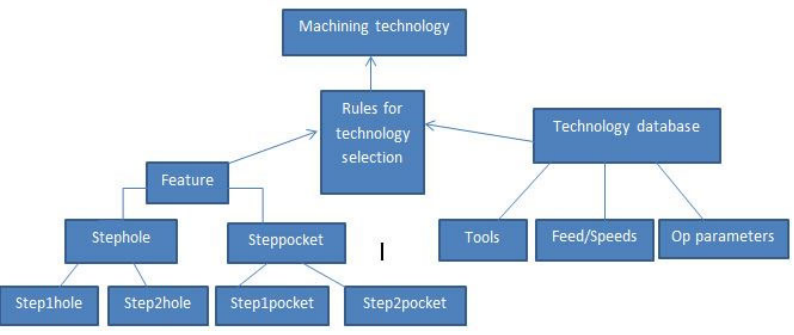
Fig. 3. Data movement in FBM